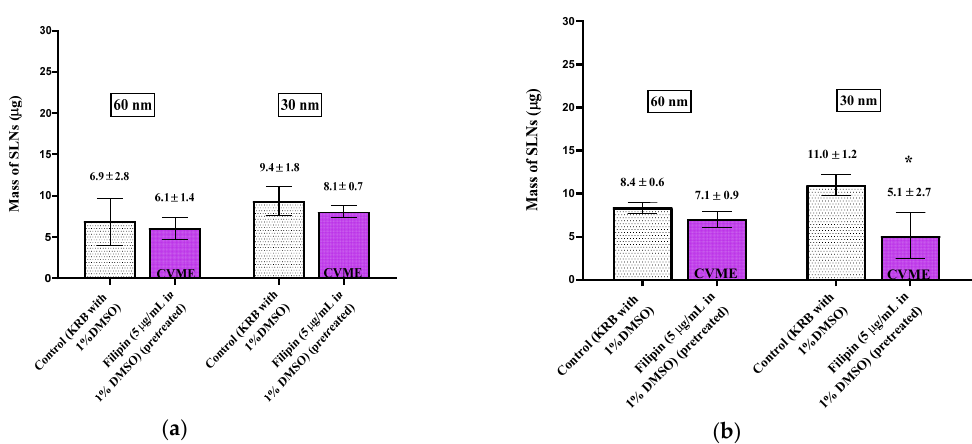
Figure 4. Uptake (30 min) of 60 and 30 nm SLNs in the nasal olfactory ( a ) and respiratory ( b ) tissues pre-treated with filipin. Bar graphs display mean nanoparticle uptake ± standard deviation determined from the recovery of Nile Red from the tissues. Statistical comparisons were made between the inhibited and control tissues using Student’s two-tailed t -test ( p < 0.05). * denotes a significant statistical difference between the inhibited and control tissues.